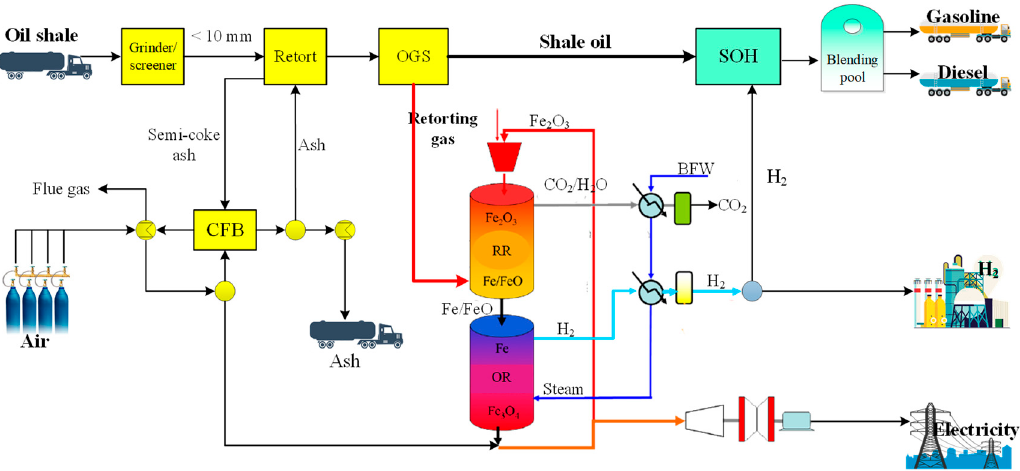
Figure 2. Schematic diagram of the proposed CLeSTL process.